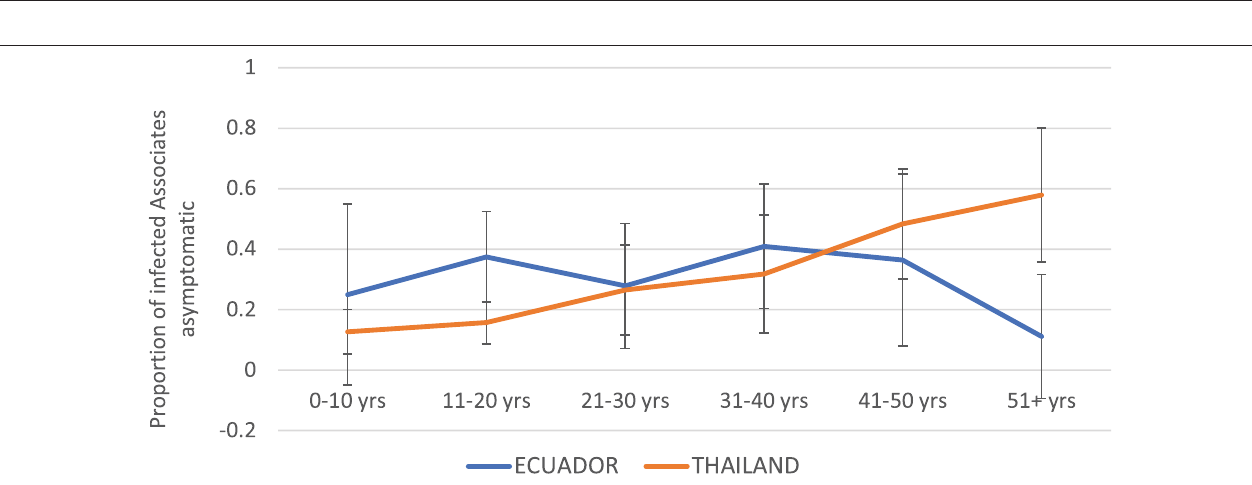
FIGURE 5 | Proportion of DENV-infected Associates with asymptomatic infection (i.e., denying any of the solicited symptoms) by age and study site. Thailand is shown in orange and Ecuador in blue. Error bars reflect the 95% confidence intervals for the proportions.